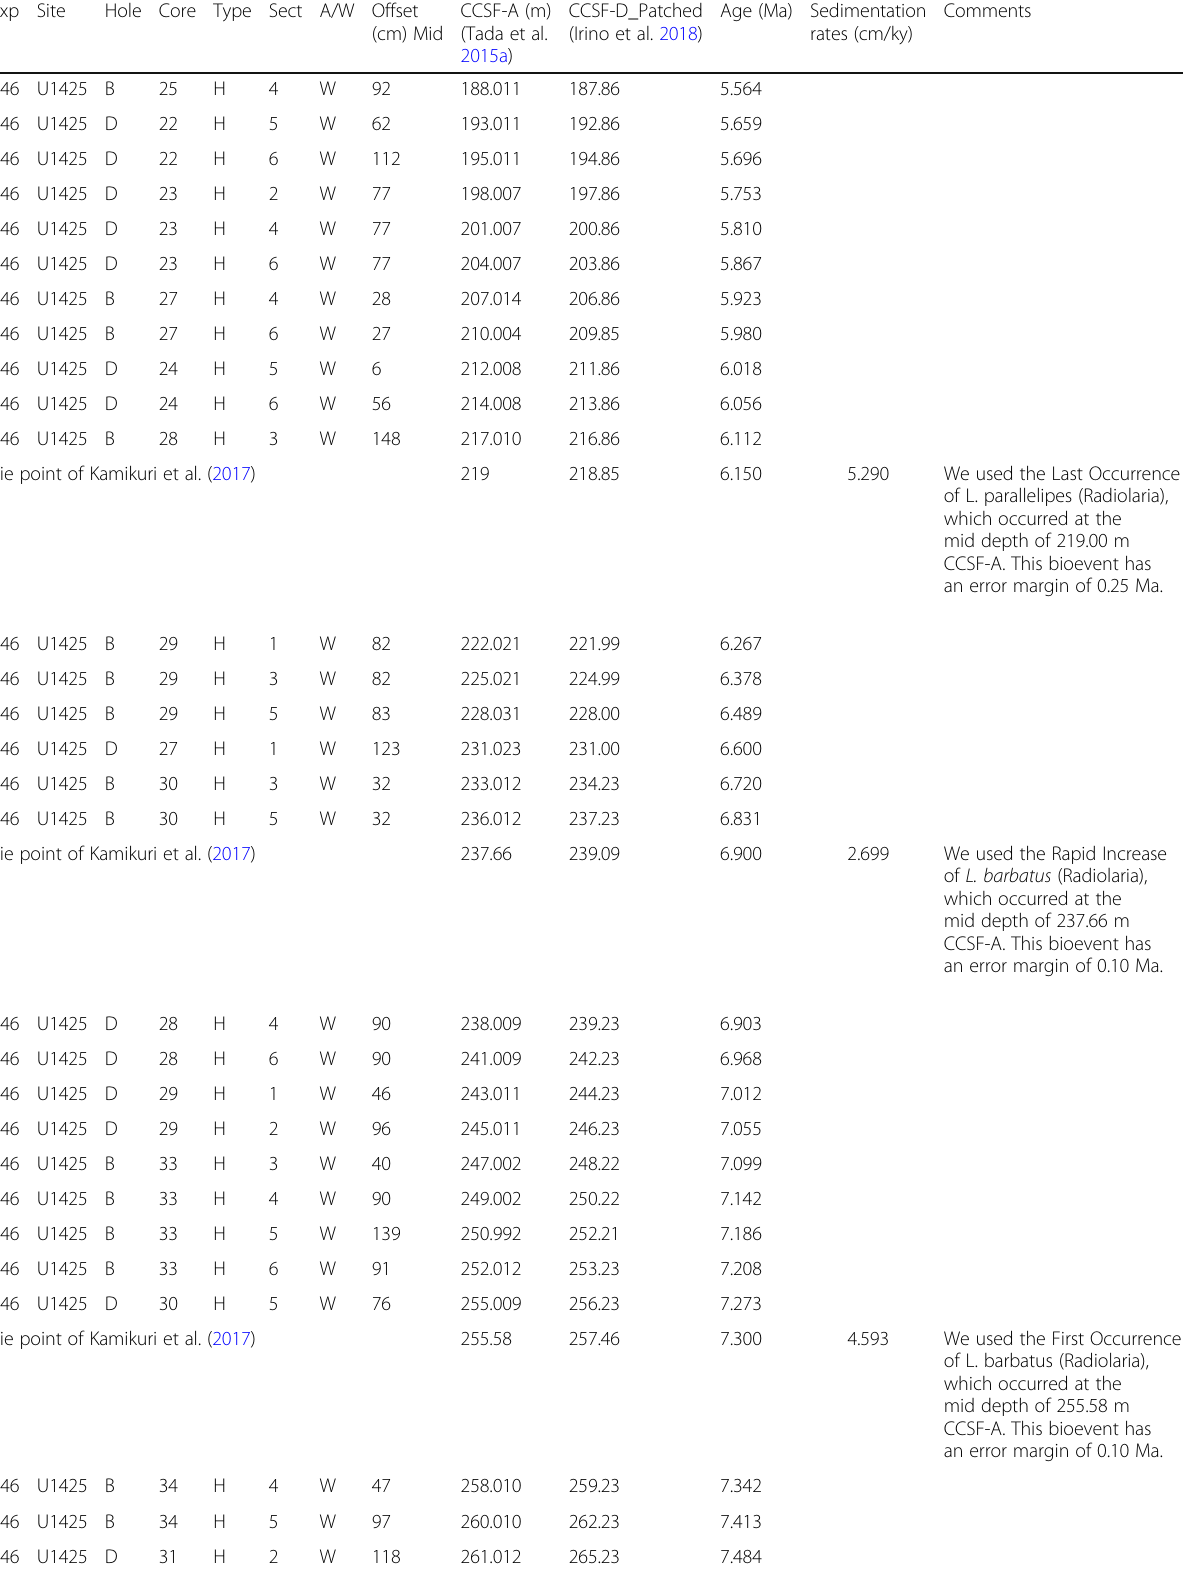
Table 1 Samples used, biostratigraphic tie points, and related sedimentation rates at IODP Site U1425 (cm/ky) (Continued) Exp